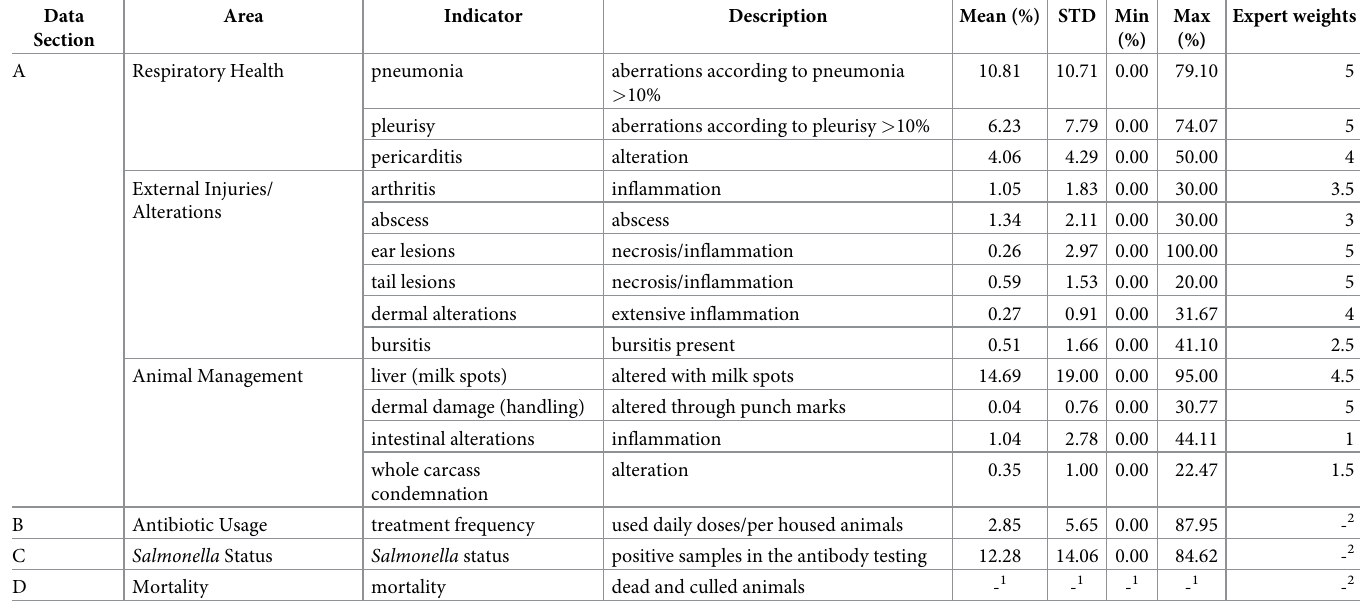
Table 2. Selected indicators with their description, mean prevalence or mean treatment frequency, standard deviation, minimum, maximum, and assigned median expert weight for meat inspection